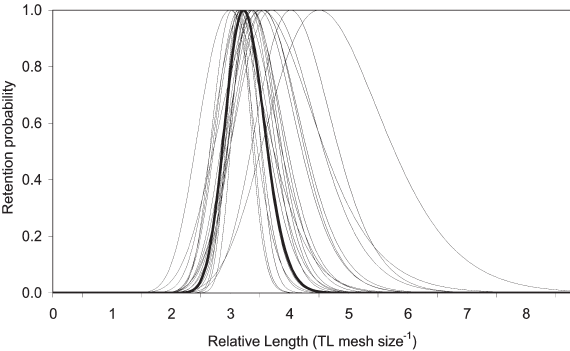
Fig. 7. – Log-normal selection curves for individual sets (thin lines) Fig. 8. – Log-normal selection curves for the 5 gill net mesh sizes and estimated mean selection curve given by REML analysis (thick used in the selectivity experiments and size-frequency distribution line). (histograms) of the soles caught in the rapido trawl trials. Dots = 64.2 mm; broken line = 65.2 mm; thin line = 67.8 mm; medium line Table 7. – Parameter estimates for the mean log-normal selection = 70.2 mm; thick line = 71.8 curve generated by the REML analysis. SD = standard deviation; DF = degrees-of-freedom. Transformed parameters are in cm.